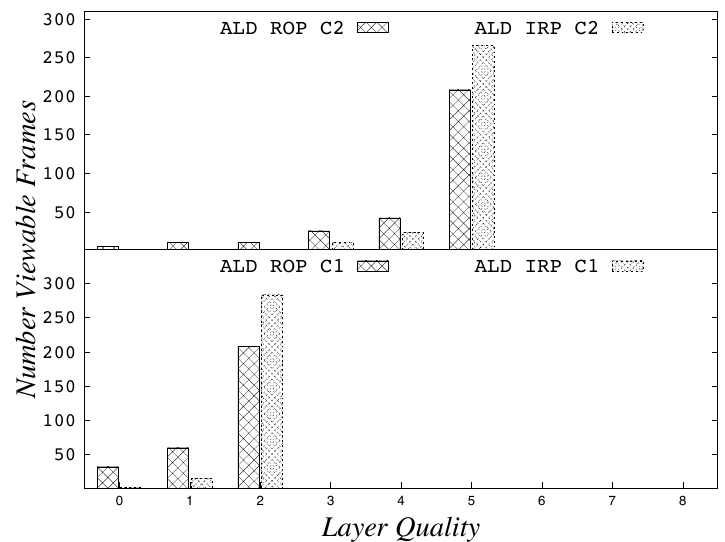
Figure 11. Viewable quality of ALD-SC for both packetisation schemes, ROP and IRP, with a loss rate of